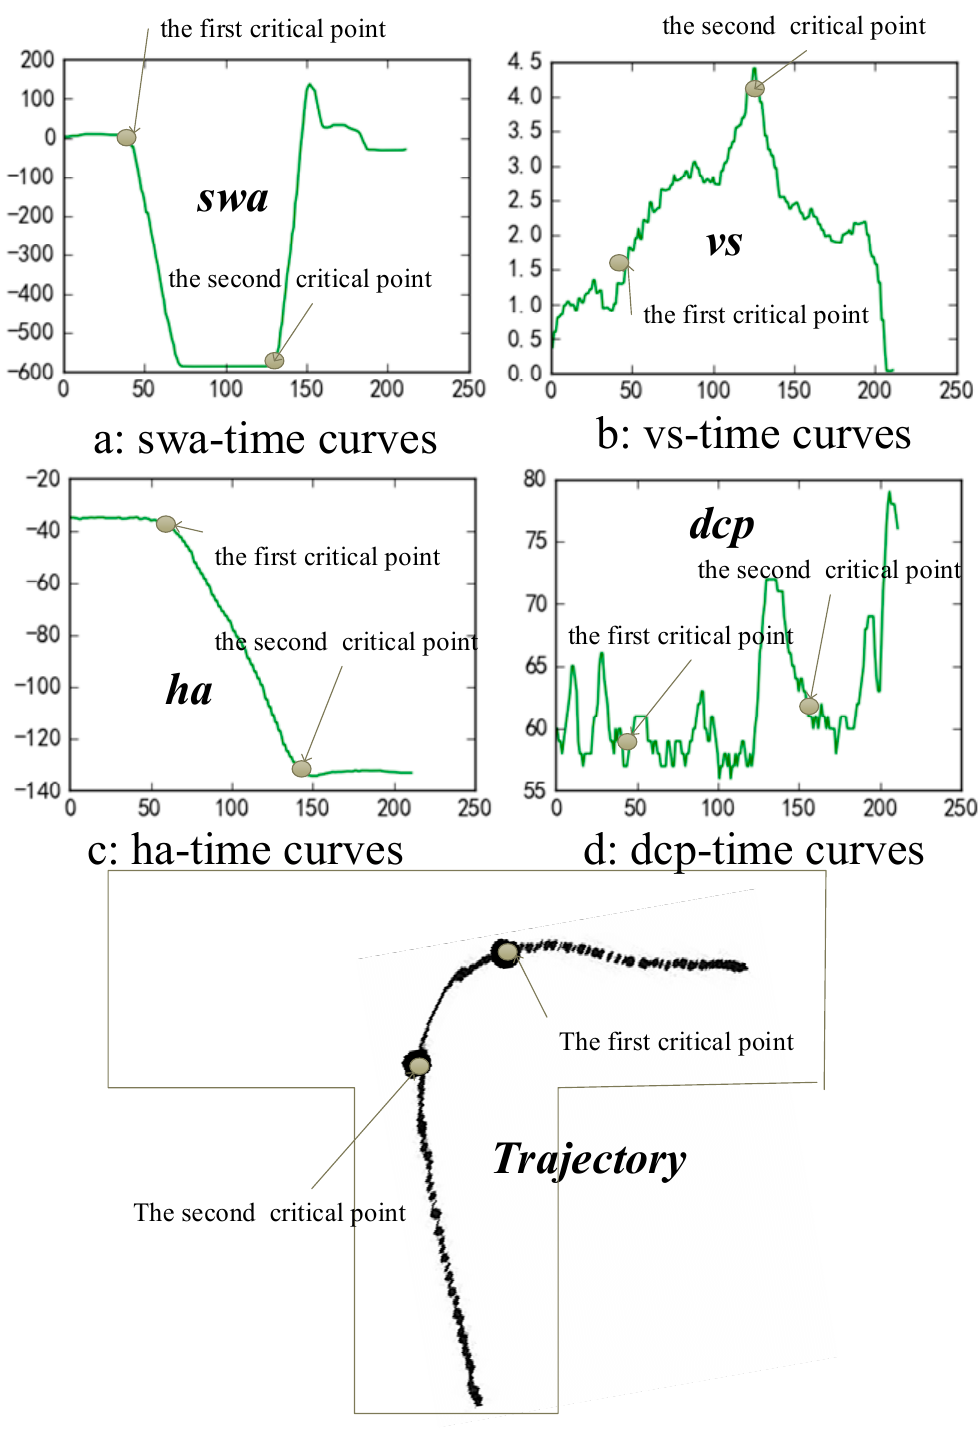
Figure 11. Curves of the four features in a specific reverse parking operation.